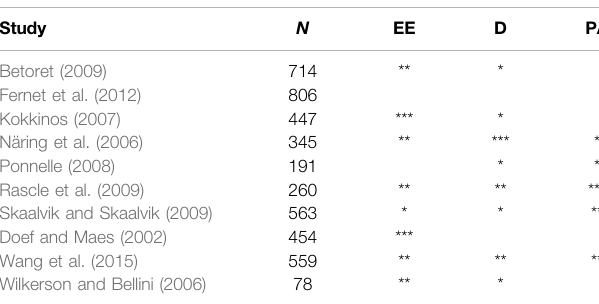
TABLE 2 | Decision Latitude and